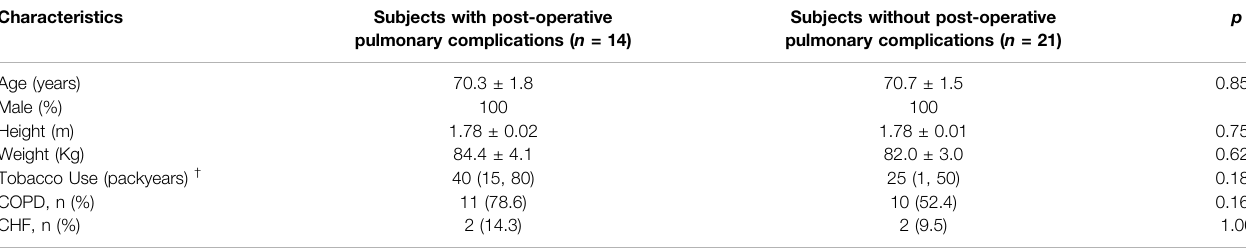
TABLE 1 | Subjects